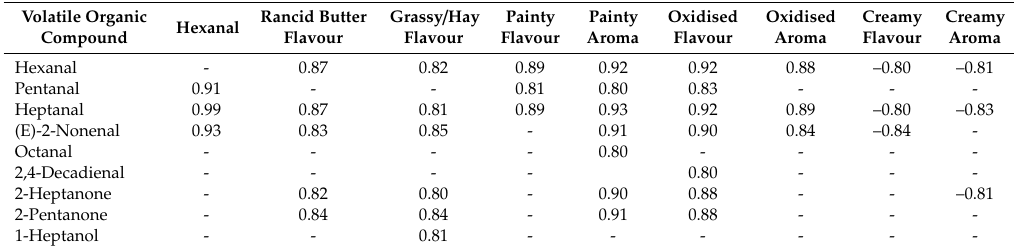
Table 4. Correlation relationships between volatile organic compounds (VOCs) and sensory attributes observed in fat-filled whole milk powder (FFWMP). Positive and negative r values indicate significant ( p ≤ 0.001) positive and negative correlations between the VOCs and sensory attributes, respectively. Volatile Organic Compound